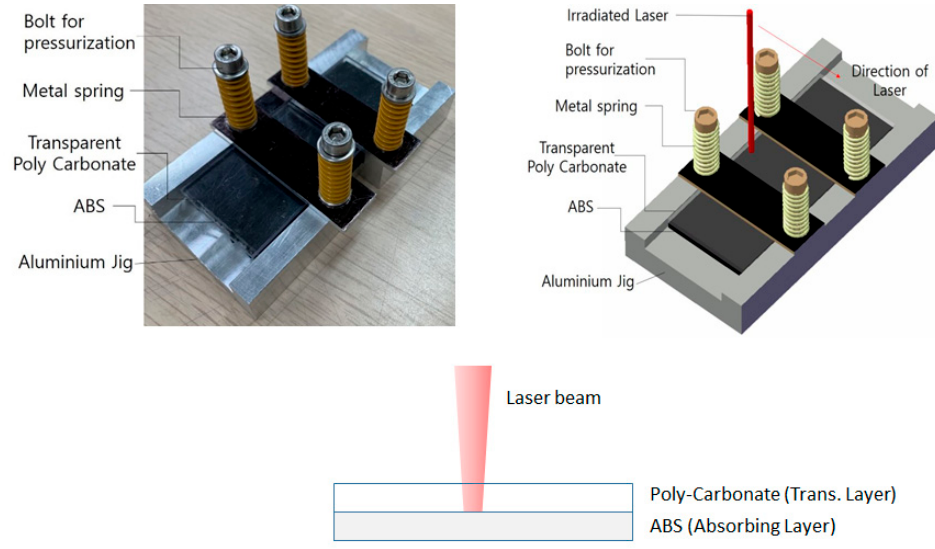
Figure 2. Welding jig configuration.